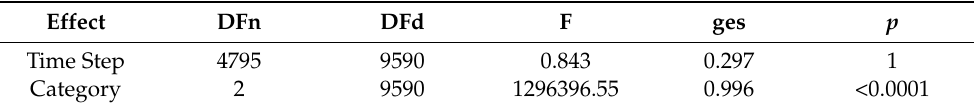
Table 3. ANCOVA of the simulated structures RMSD (residues 49–94) after adjusting for the time steps.